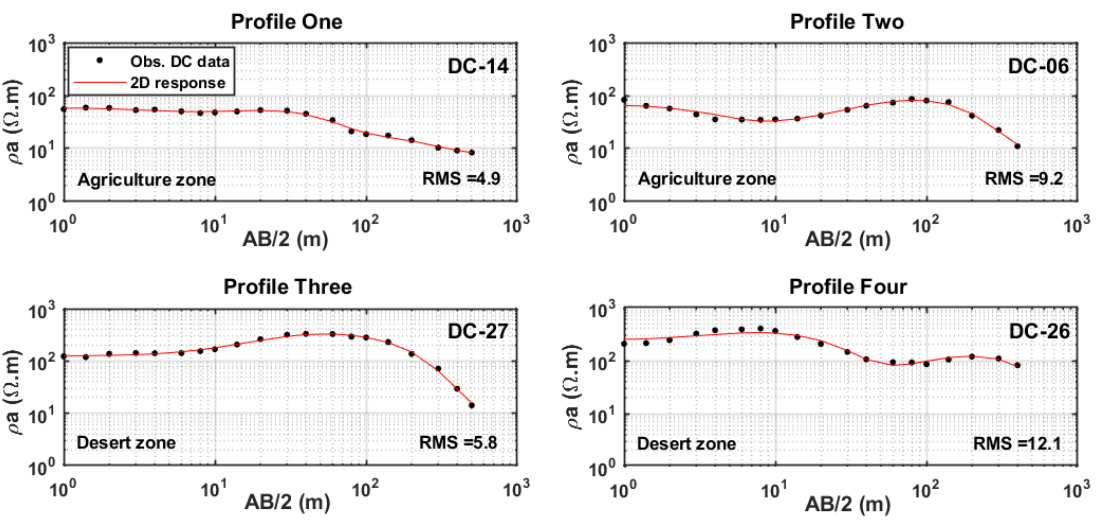
Figure 12. Comparison of the observed and 2D synthetic data of some selected VES sites along all profiles.